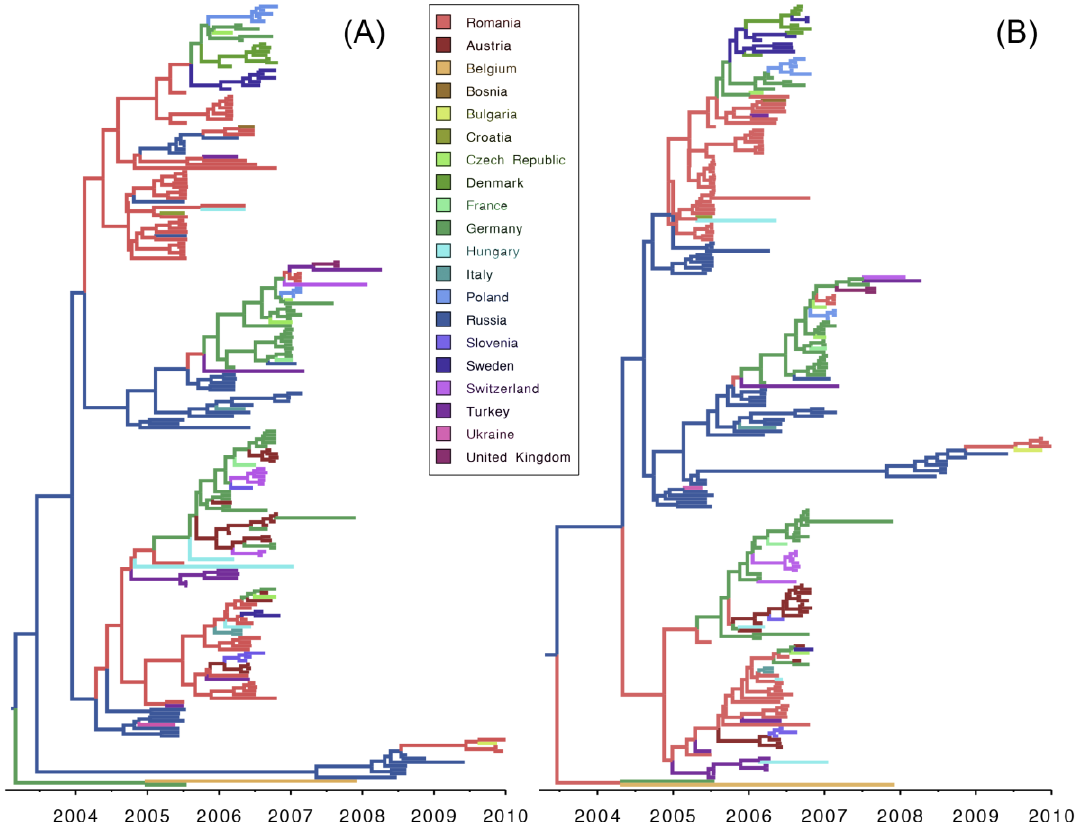
Figure 3. Maximum clade credibility (MCC) tree for H5N1 HPAIV hemagglutinin (HA; A ) and neauraminidase (NA; B ) gene regions. Branch lengths are rendered proportional to absolute time (see timescales), and branches are colored according to the most probable geographic location.